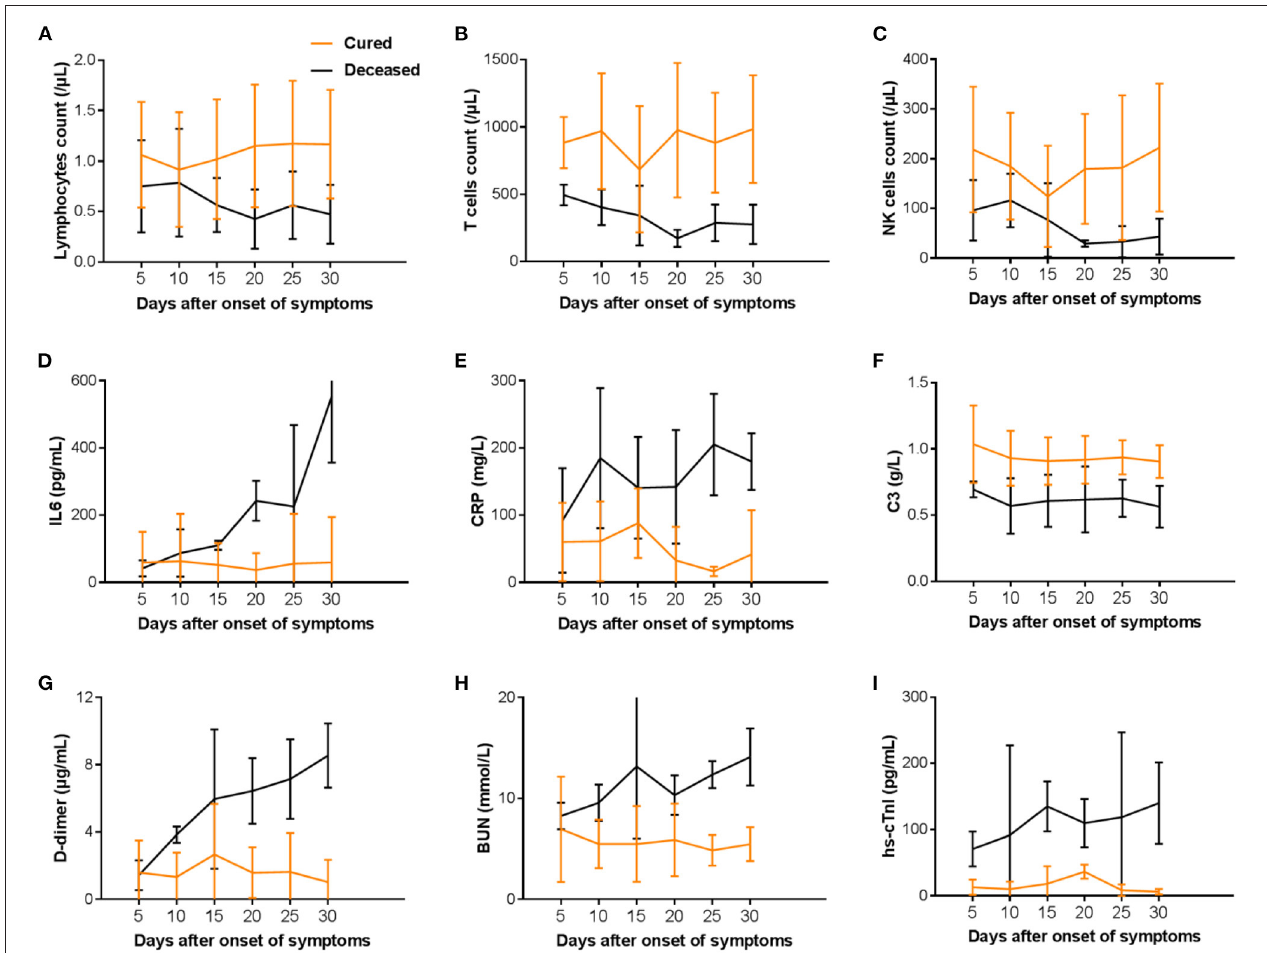
FIGURE 4 | Temporal changes in laboratory markers (A–I) in hospitalized patients since onset of COVID-19. T cell, T lymphocyte; B cell, B lymphocyte; NK cell, nature killer cell; IL6, Interleukin 6; CRP, C-reactive protein; C3, complement component 3; BUN, Blood urea nitrogen; hs-cTnI, High-sensitivity cardiac troponin I.